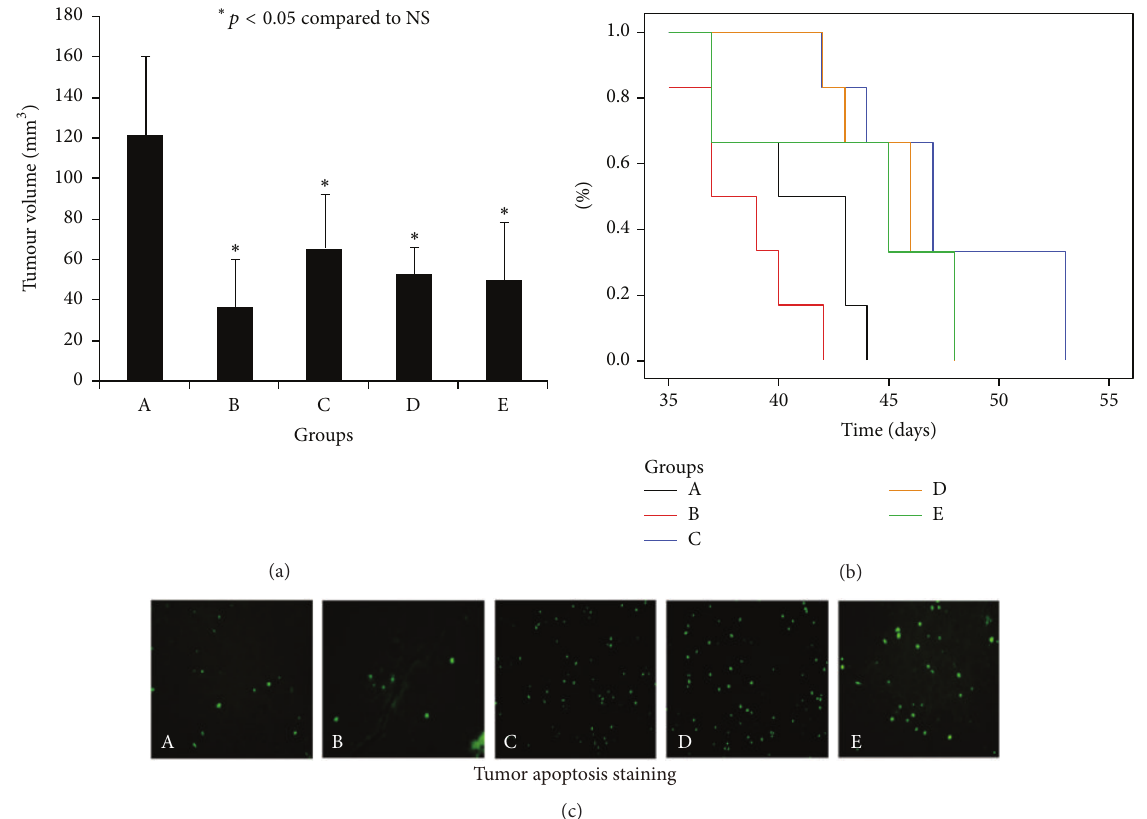
Figure4:EffectofBufalinontumorvolume,animalsurvival,andapoptosis.Bufalintreatmentsignificantlyinhibitedtumorgrowthcompared to the control group ( 𝑃 < 0.05 ) (a), prolonged survival time ( 𝑃 < 0.01 ) (b), and increased apoptosis in tumor (c). Groups: A: control, B: 5-FU,